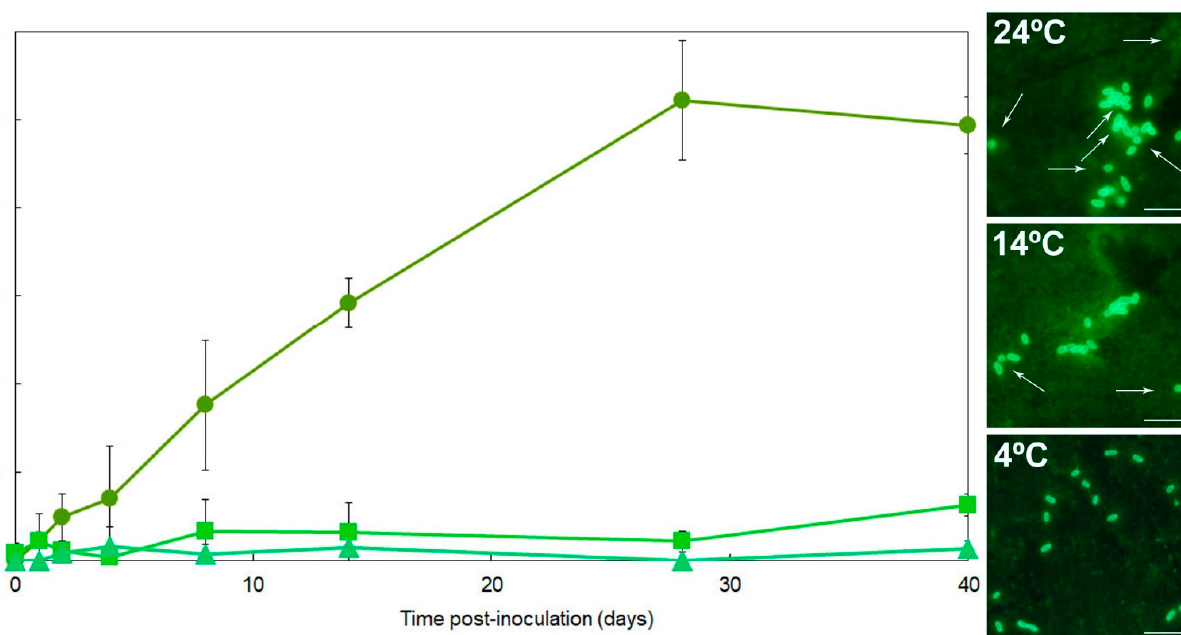
Figure 2. Similarity in trends of culturable cell counts from Ralstonia solanacearum strain IVIA-1602.1- inoculated environmental water microcosms throughout 40-day periods at 4 °C and 24 °C. Inc stands for Increments, which were calculated with the differences between mean values of culturable data at both temperatures with respect to the values at time zero (Inc zero). ( Left ): comparison of culturable data on SMSA medium among environmental water (EW) − 1 ( ♦ ), EW − 2 ( ● ), EW − 3 ( ▲ ), and EW − 4 ( ■ ). ( Right ): comparison between culturable data on SMSA ( ■ ), and YPGA ( ▲ ) media for the four environmental water samples.